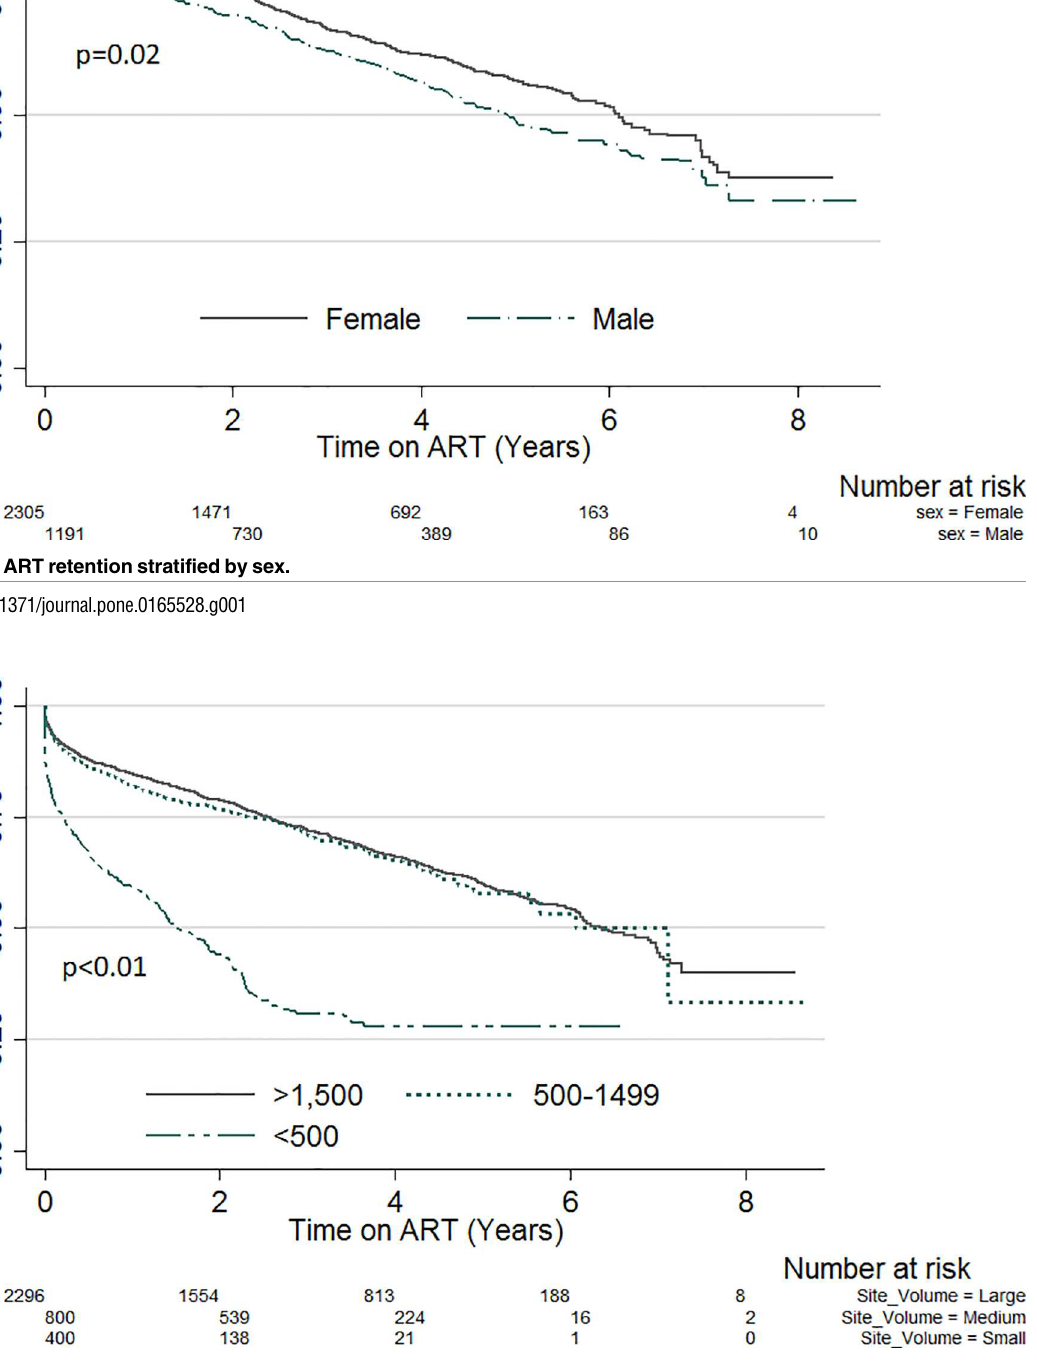
Fig 2. ART retention stratified by ART patient